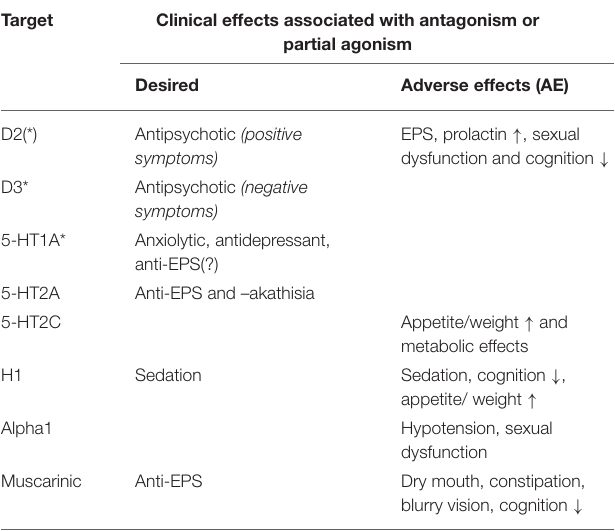
TABLE 2 | Key antipsychotic targets + associated drug benefit and AE impact examples.